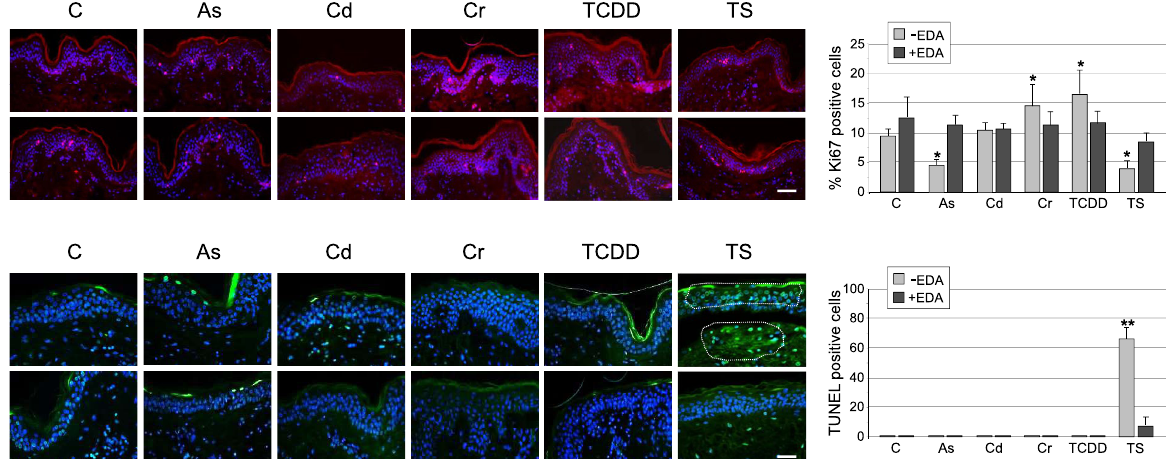
Figure 2. Deschampia antarctica aqueous extract (Edafence) counteract the alterations in cell proliferation patterns induced by acute exposure of Human Skin Organ Cultures to common ambient pollutants. HSOC histological sections from control samples (C) or samples exposed to As(III), Cd(II), Cr(VI), 2,3,7,8-tetrachlorodibenzo-p-dioxin (TCDD) or Tobacco Smoke culture medium infusions (TS) pre-treated or not with Deschampia antarctica aqueous extracts (EDA) showing ( A ) the fluorescent localization of the proliferation marker Ki-67 (left panel; bar: 100 µm) together with the quantification of the % of Ki-67 positive cells in each sample group (right panel), and ( B ) the fluorescent localization of apoptotic cells by the TUNEL assay (left panel, dotted lines delimit areas of a high TUNEL-positive cell content; bar: 50 µm) together with the quantification of the % of TUNEL positive cells in each sample group (right panel). Images are representative of at least three different samples for each experimental condition. For quantifications, the ratio of positive cells for the indicated proteins in histological sections of HSOC samples was calculated as described in the Methods section. The mean + SD of the positive cell average (%) in three different samples for each experimental condition is represented (*, significant p ≤ 0.1; **, significant p ≤